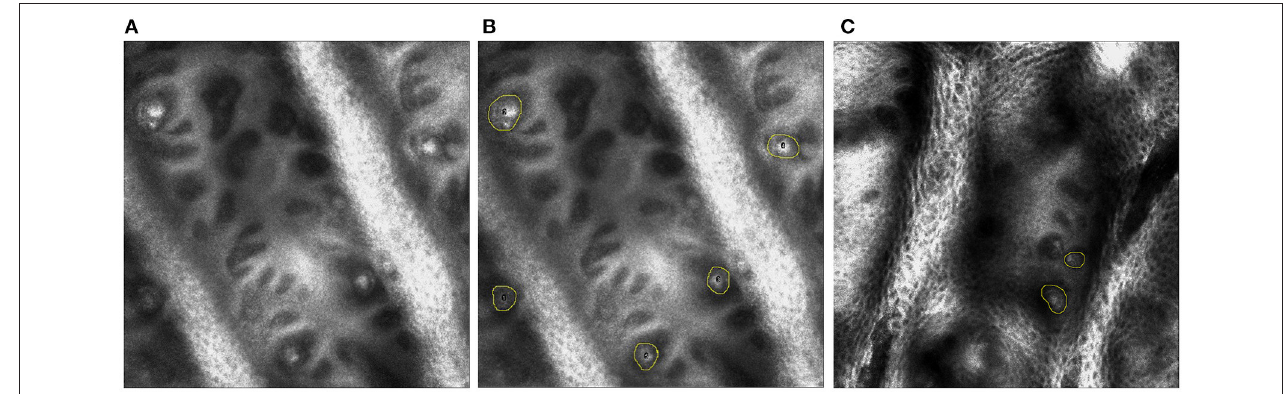
FIGURE 3 | (A) On the left, single plane image from in vivo reflectance confocal microscopy of digit V. (B) In the middle, the MCs are identified by yellow circles in a healthy control. (C) On the right, MCs are identified by yellow circles in an individual with CMT 1A.